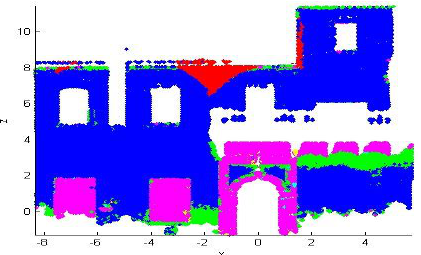
Figure 8. Brightness variation effect on the results of the segmentation: result with td = 0.2m, tr = 10, Vr = 100 and tr 2 = 40. 10 segments (appearing as different colors) are found.